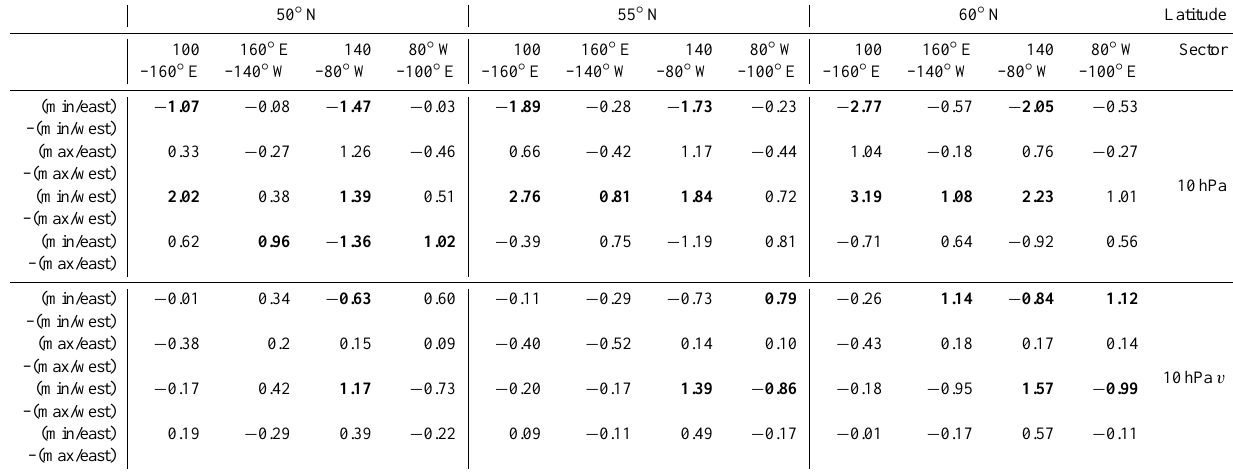
Table 3. Winter (December–February) differences of wind speed (ms − 1 ) for different latitudes and sectors during the whole period. Top panels show the total horizontal wind speed for 10hPa; bottom panels show the v (meridional) wind component for 10hPa. Min/east: years under solar minimum and the east phase of QBO conditions; min/west: years under solar minimum and the west phase of QBO; max/east: years under solar maximum and the east phase of QBO conditions; max/west: years under solar maximum and the west phase of QBO. Significant differences at the 95% level are highlighted in bold.